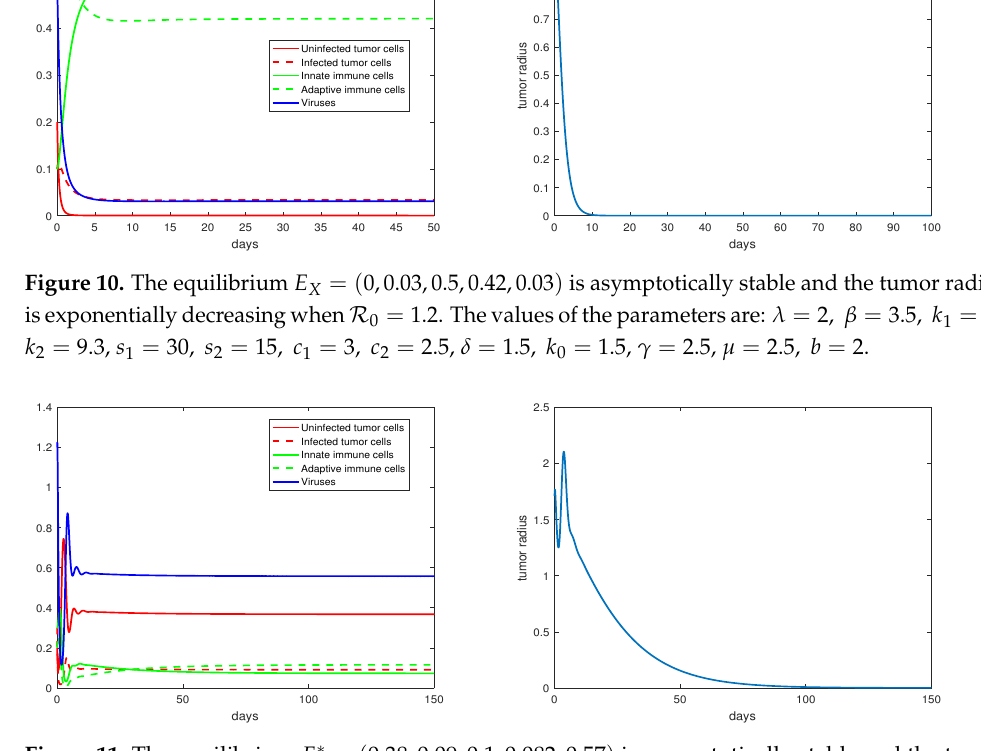
− f 0 = 2.4, R = 5.84 } . The 4 λ δ y ∗